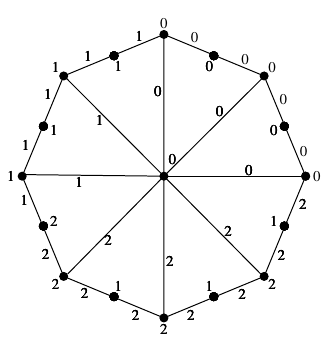
Fig. 13 3-TEPC labeling of G